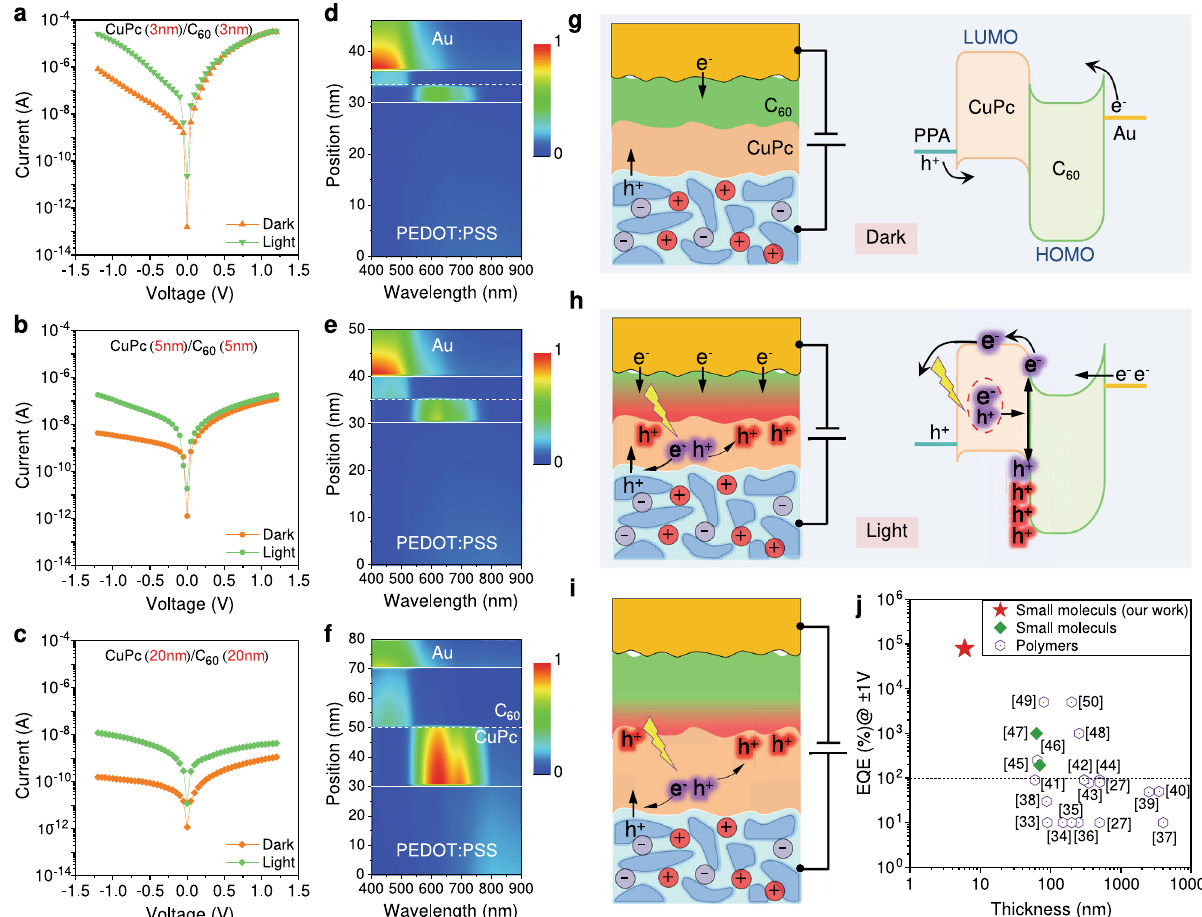
Fig. 3 Molecular photomultiplication photodiodes based on PPA30/CuPc ( x nm)/C 60 ( x nm)/Au tube. a – c I - V characteristics of the molecular devices in the dark and under light illumination ( a x = 3 nm; b x = 5 nm; c x = 20 nm). The bottom electrode is grounded during the I - V measurement. Both the dark and photo currents increase with the decrease in thickness, while the photo/dark current ratios remain close to 100. d – f Simulation of photogenerated exciton distribution in the molecular devices ( d x = 3 nm; e x = 5 nm; f x = 20 nm). g , h Schematic showing the molecular devices with an ultrathin respectively. Trapped photogenerated holes by the C 60 layer are marked as red-glowing “ h + ” . The red gradient area represents the region affected by